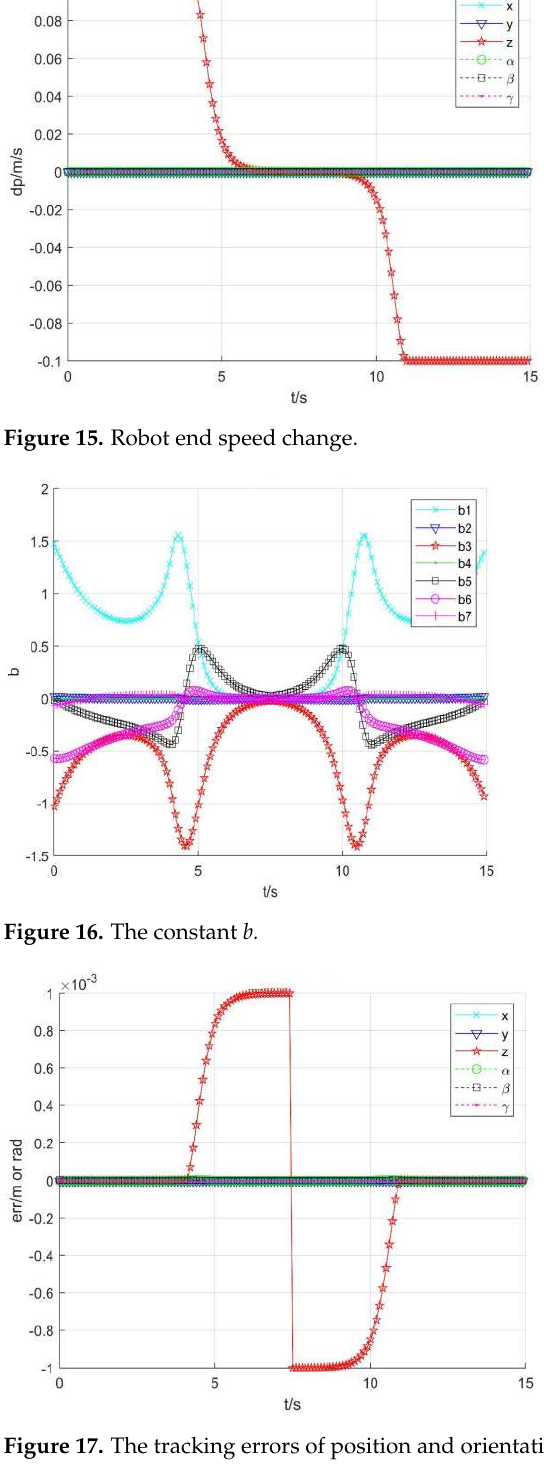
Figure 17. The tracking errors of position and orientation.